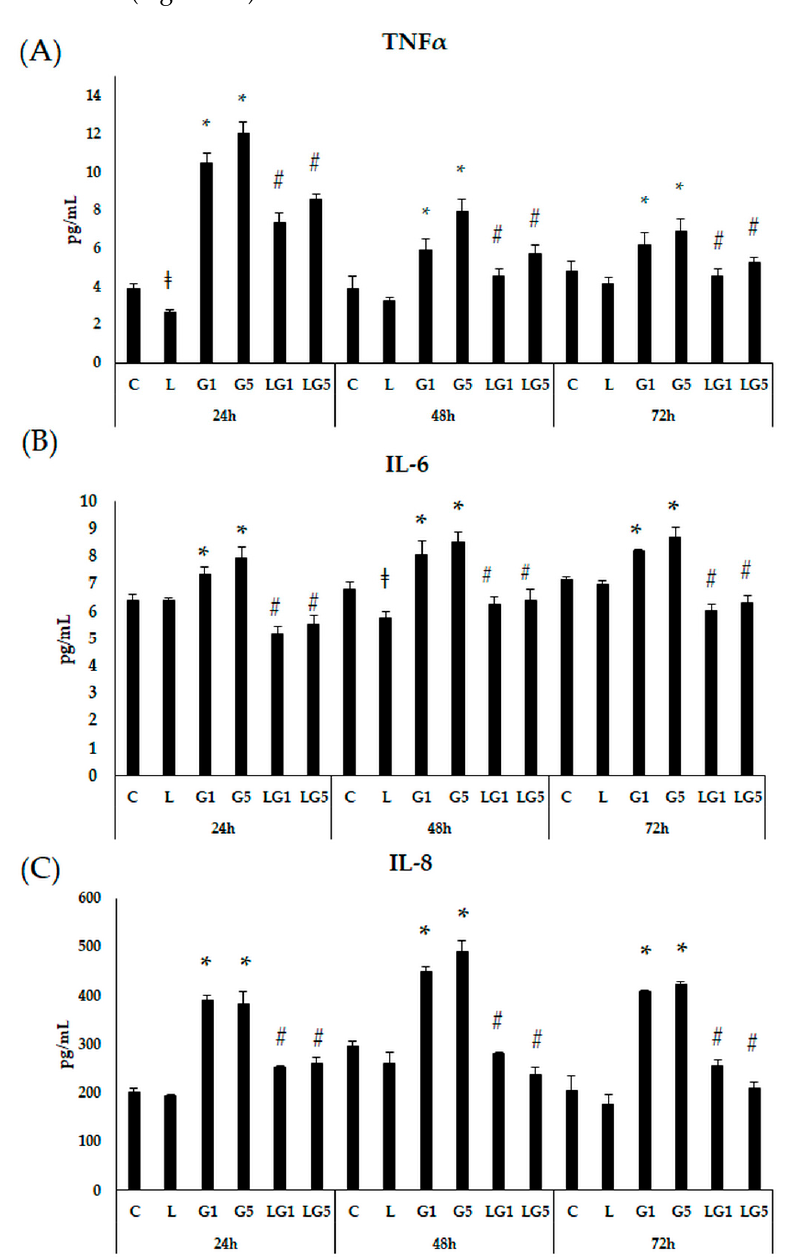
Figure 4. Determination of proinflammatory TNF α ( A ), IL-6 ( B ), and IL-8 ( C ) secretion after lutein and Glu treatments of the SH-SY5Y cells. SH-SY5Y cells were treated with 10 ng/µL of lutein, 1 mM, 5 mM Glu, or lutein with Glu together to detect the changes in the secretion. The cells were incubated for 24 h, 48 h, and 72 h at 37 °C and 5% CO 2 . After incubation, the cell culture media was used to determine the cytokine secretion by human TNF α ELISA kit ( A ), by human IL-6 ELISA kit ( B ) by human IL-8 ELISA kit ( C ), and the result was expressed as pg/mL. The bars represent the mean values (±standard deviation error bars, SD) of three independent experiments ( n = 3) performed in triplicate and are presented relative to their control cells. The * marks the statistical significance of Glu treatments compared to control, ǂ shows the statistical significance of lutein treatments compared to control, # signs the statistical significance of combined (lutein with Glu) treatments compared to the Glu treatments at 24 h, 48 h, and 72 h ( p < 0.05).